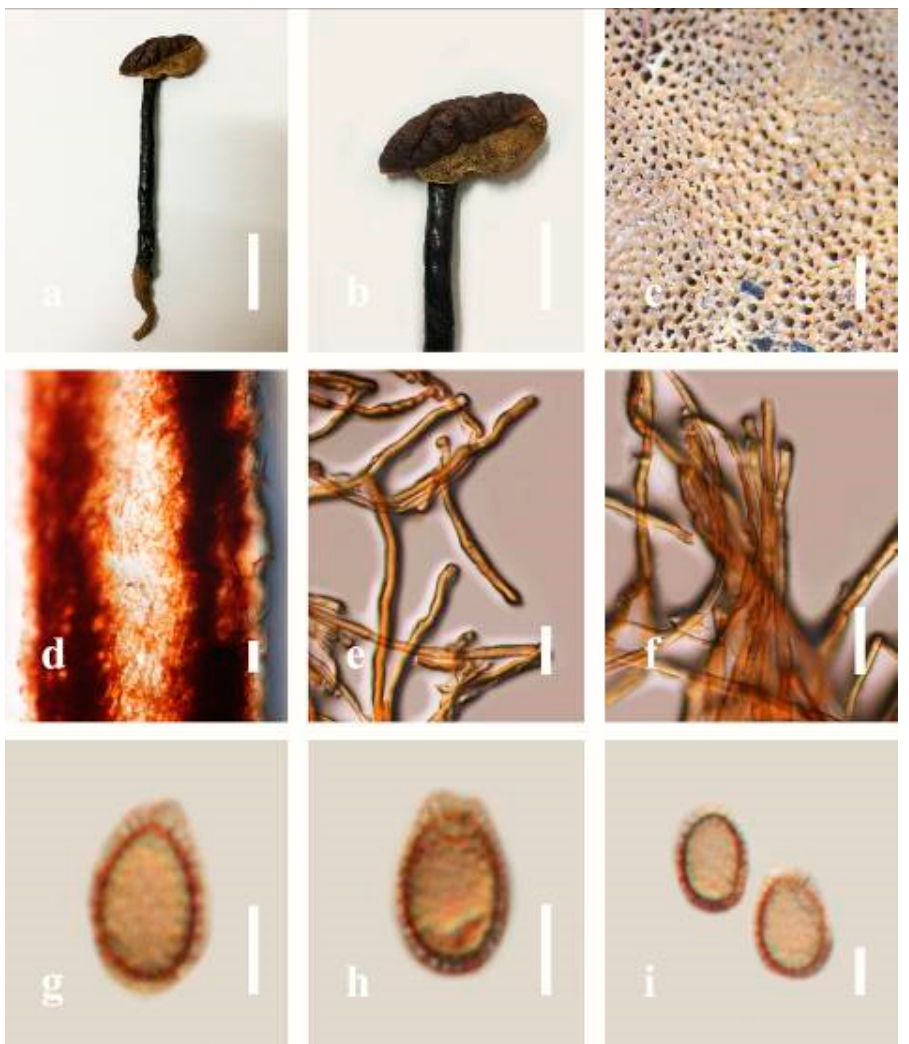
Figure 7. Morphology of Ganoderma flexipes (MFLU 19 ‐ 2189): ( a , b ) mature basidiomes; ( c ) pore characteristics; ( d ) hyphae of tube layers in Melzer’s reagent; ( e , f ) context hyphae in Melzer’s reagent; ( g – i ) basidiospores. Scale bars: ( a ) = 3 cm, ( b ) = 2 cm, ( c ) = 500 μ m, ( d ) = 30 μ m, ( E , F ) = 20 μ m, ( G – I ) = 5 μ m.